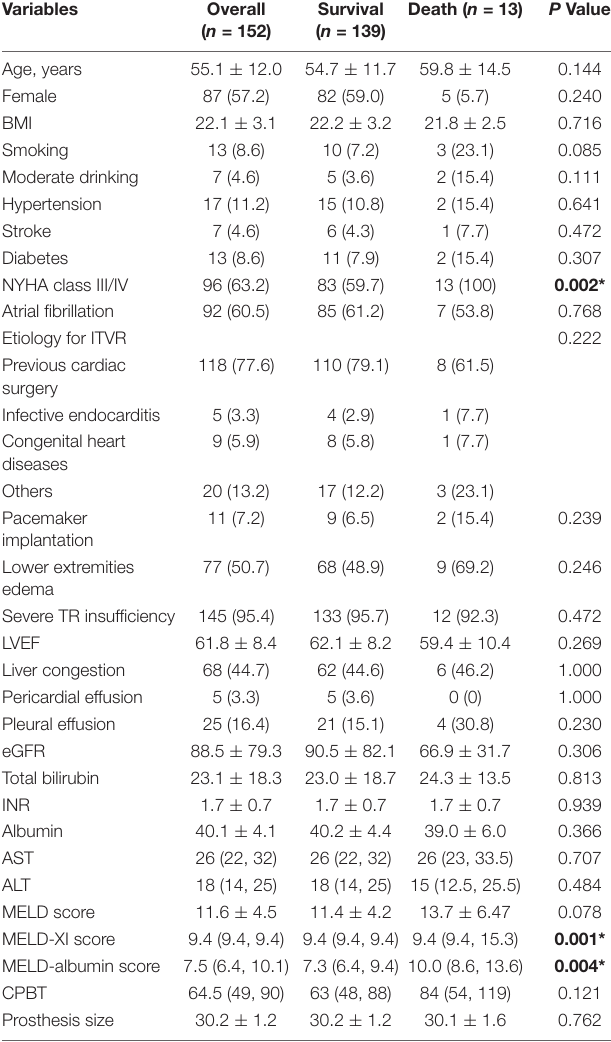
a BMI, body mass index; NYHA, New York Heart Association classification; TR, tricuspid regurgitation; LVEF, left ventricular ejection fraction; INR, international normalized ratio; eGFR, estimated glomerular filtration rate; AST, aspartate transaminase; ALT, alanine transaminase; MELD, Model for End-stage Liver Disease; MELD-XI, Model for End-stage Liver Disease excluding international normalized ratio; MELD-albumin, Model for End-stage Liver Disease with albumin replacing international normalized ratio. The value of P < 0.05 was noted as bold value with